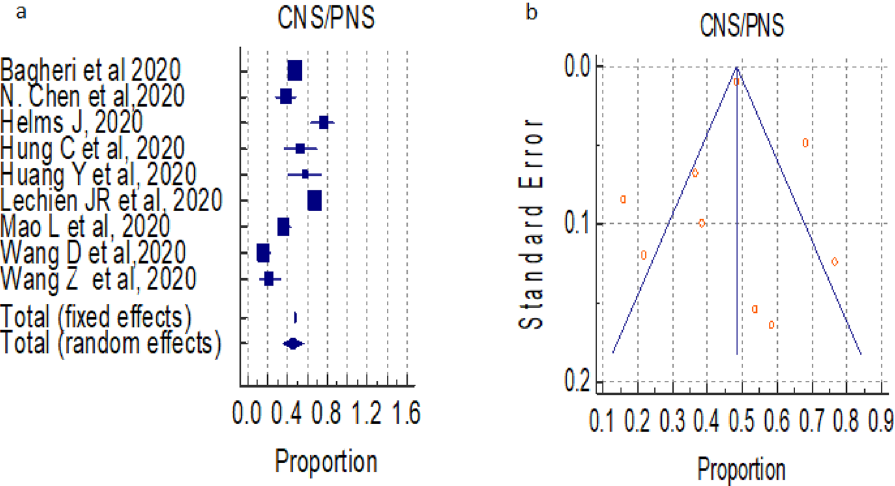
Figure 2. ( a ) Forest plot showed pooled prevalence of CNS-PNS combined among patients with COVID- 19 patients. ( b ) Funnel plot showed publication bias among studies evaluating neurological complications of COVID-19.